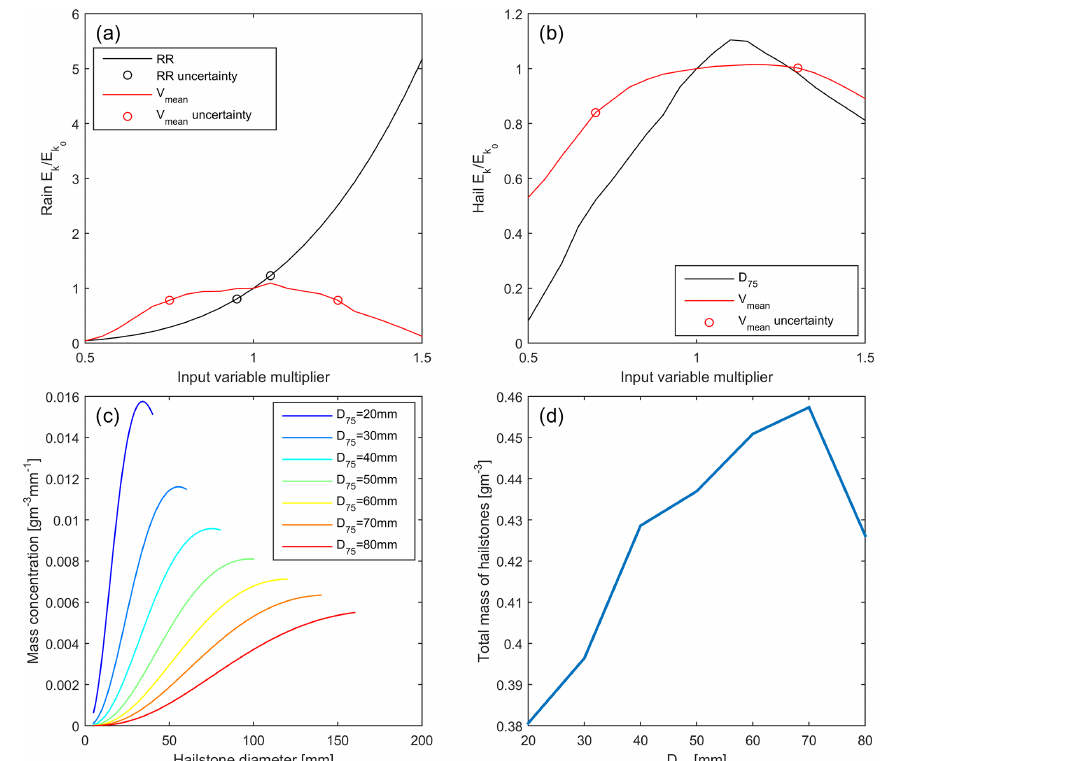
Figure 8. Sensitivities of rain (a) and hail (b) impact kinetic energies in one 5min period to the application of ± 50% uncertainties on the input parameters; wind speed ( V mean ) and precipitation intensity (RR) or hail diameter ( D 75 ). Circles represent reported uncertainties in radar retrievals of wind speed (Fast et al., 2008) and rainfall rate (see Table 1 in Seo and Krajewski, 2010). (c) Mass concentrations of hailstones per cubic meter of air (expressed as d M/ d D ) associated with a range of D 75 values as a function of hailstone diameter. (d) Total hail mass (in grams) per cubic meter of air as a function of D 75